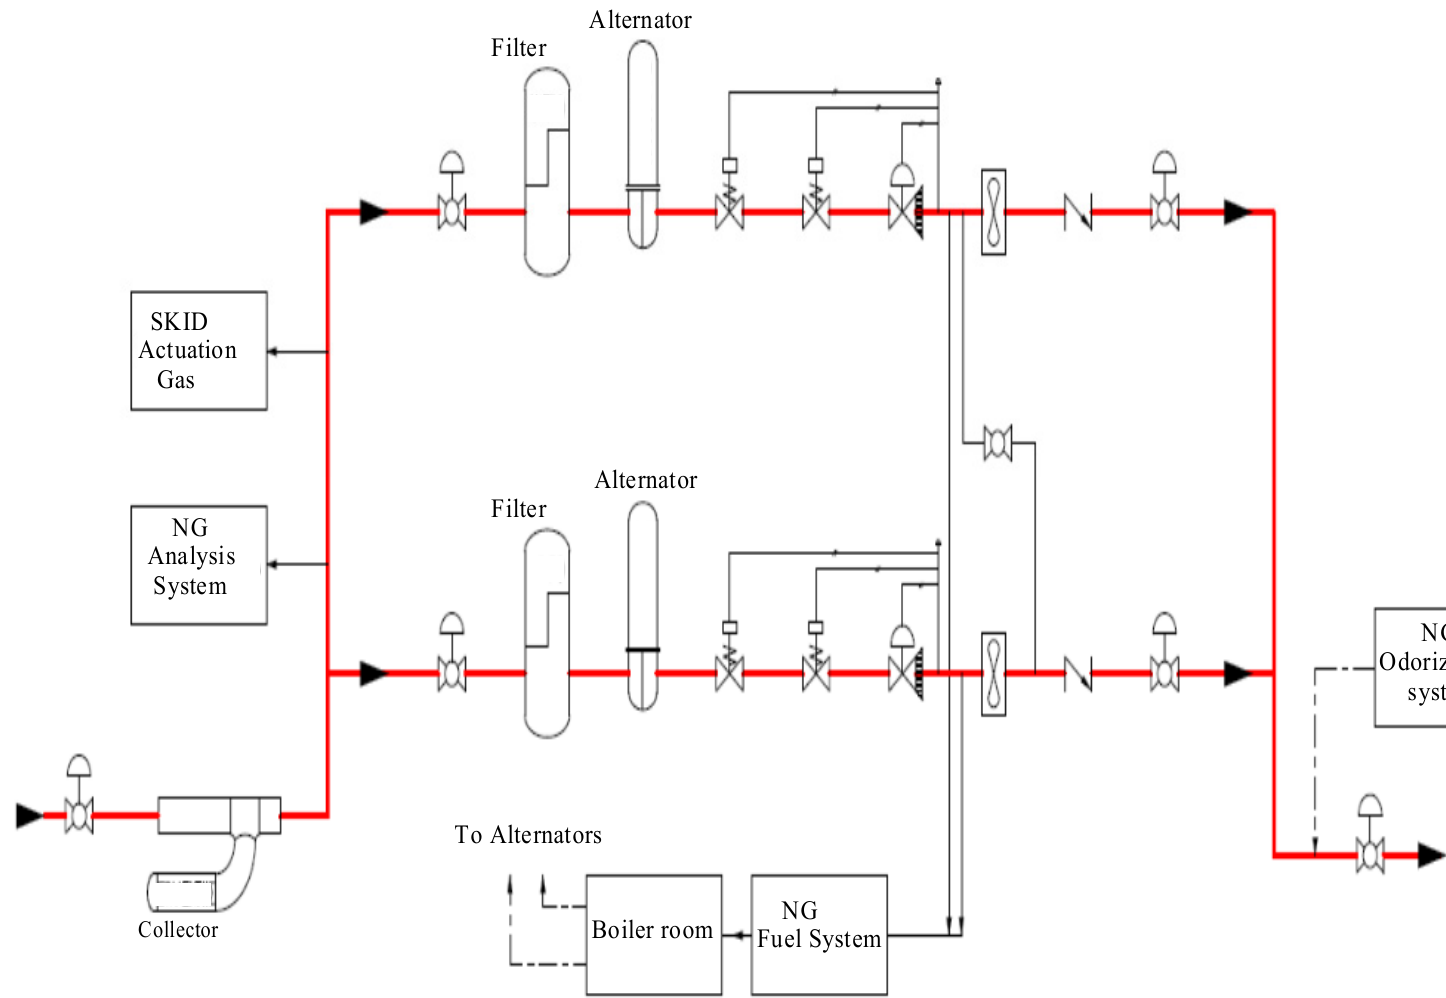
Figure 3. The process flow diagram of an MRS/GTS station.